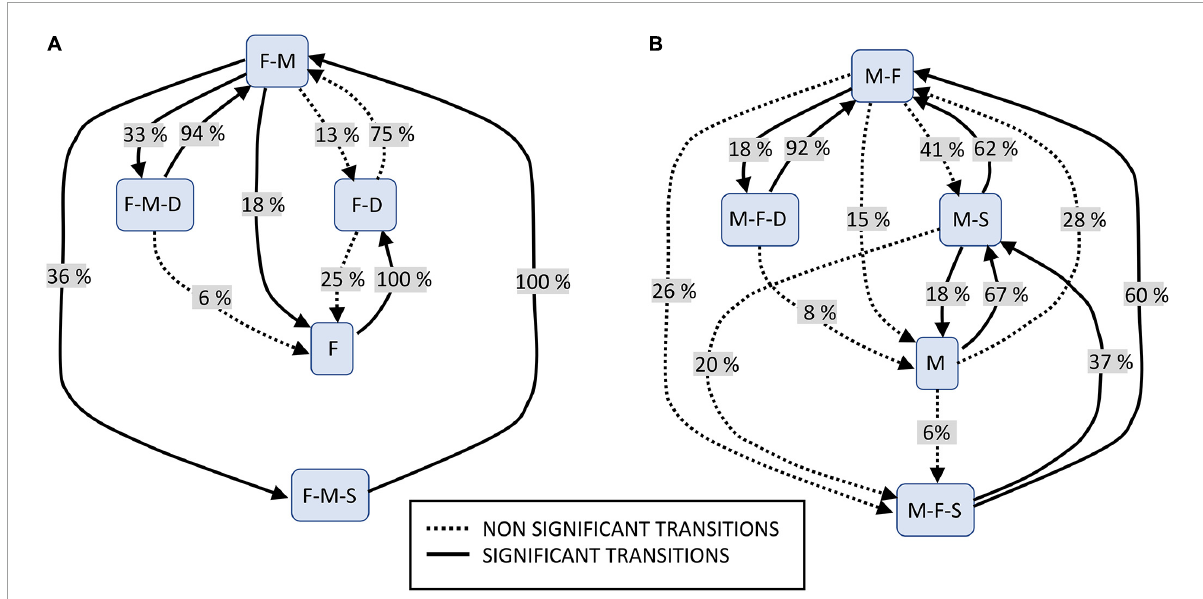
FIGURE2 Flow diagram showing the occurrence of transitions (%) between different types of co-singing. (A) Fathers: FM, fathers’ contribution when duetting with mothers; FMS, when duetting with mothers and sons; FD, when duetting with daughters; FMS, when duetting with mothers and sons; F, fathers’ phrases with no overlap with any group members. (B) Mothers: MF, mothers’ contribution when duetting with fathers; MFD, when duetting with fathers and daughters; FMS, when duetting with fathers and sons; MS, when duetting with sons; M, mothers’ phrases with no overlap with any group